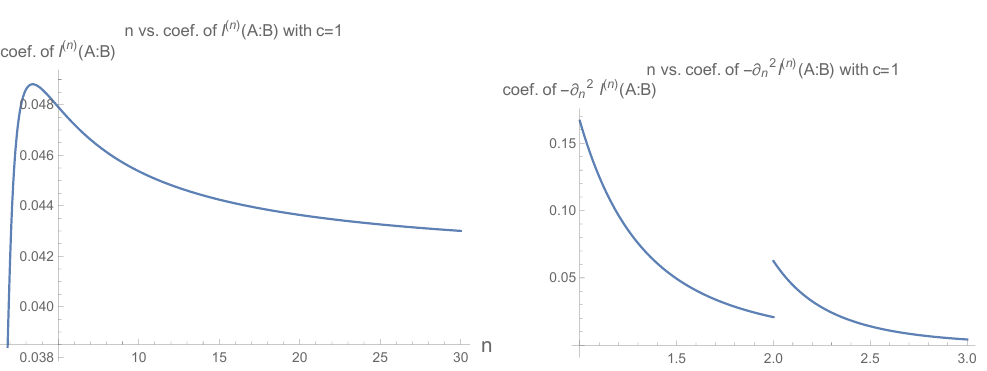
I ( n ) ( A : B ). One can n